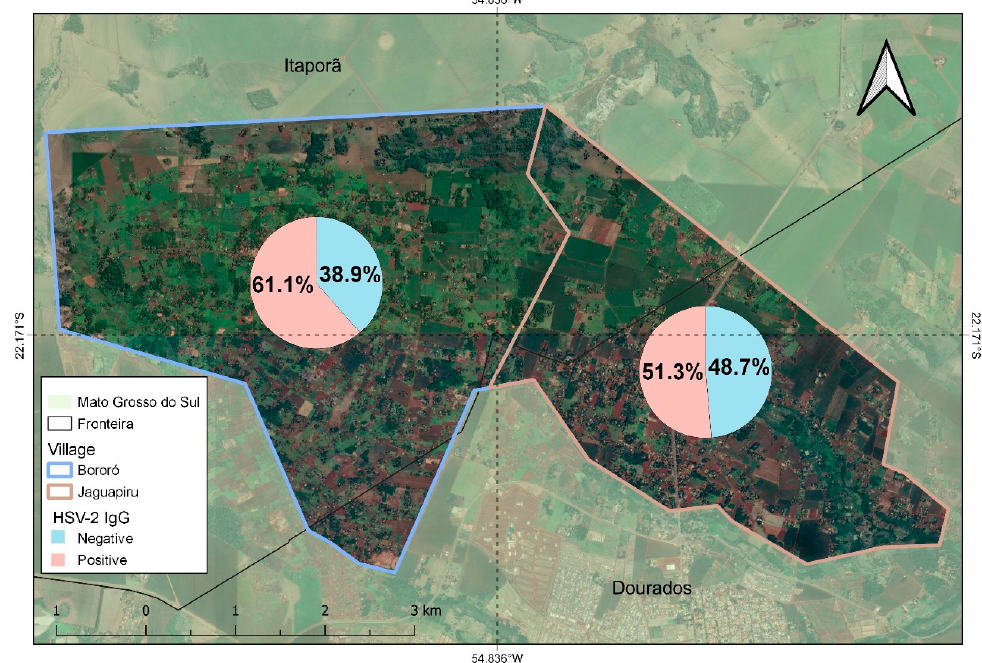
Figure 2. Distribution of anti-HSV-2 IgG prevalence positive and negative prevalence in Bororó and Jaguapirú villages (Dourados, Mato Grosso do Sul (MS), Brazil). The difference between anti-HSV-2 IgG prevalence in the Guarani-Kaiowá (58.8%) and Terena (46.3%) was statistically significant. The difference in anti-HSV-2 IgG preva-